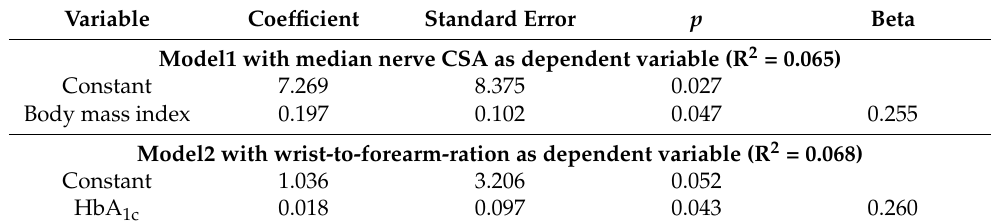
Table 3. Linear regression.